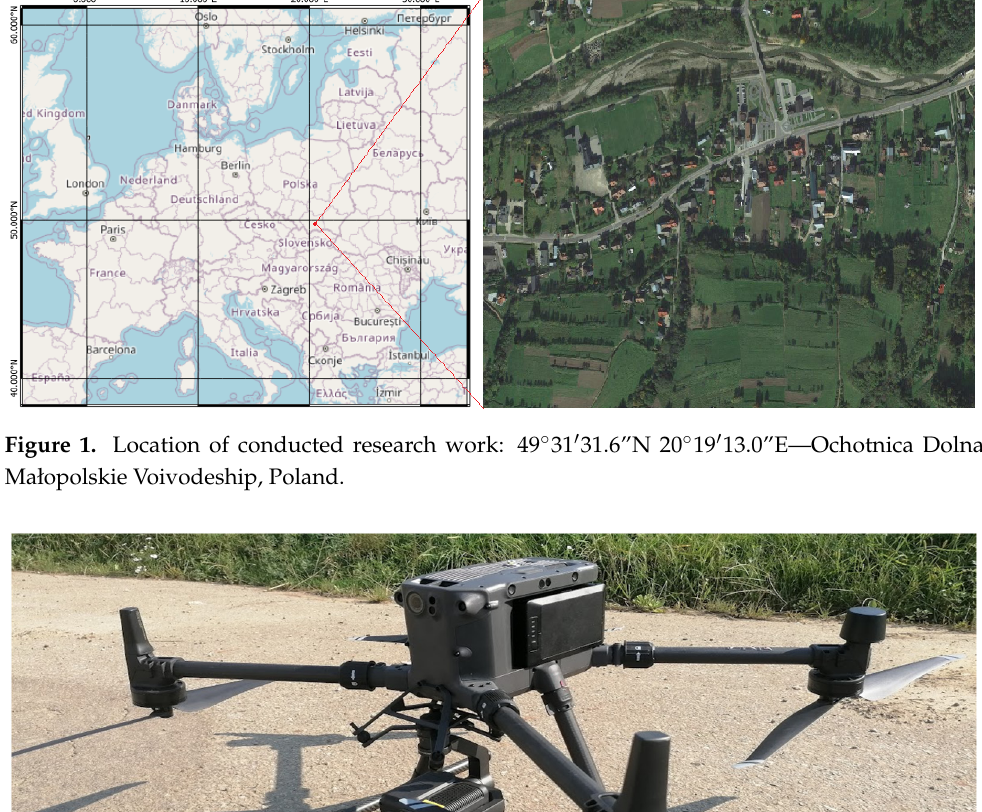
Figure 1. Location of conducted research work: 49°31 ′ 31.6 ″ N 20°19 ′ 13.0 ″ E—Ochotnica Dolna, Ma ł o- polskie Voivodeship, Poland.